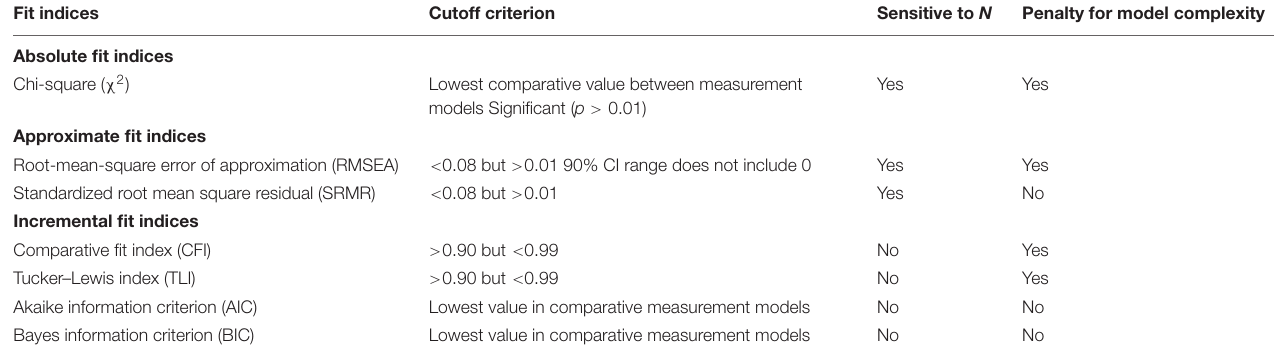
TABLE 2 | Model fit statistics.